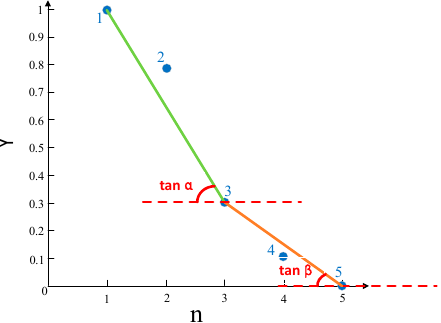
Algorithm 2: Automatic selection of clustering centers